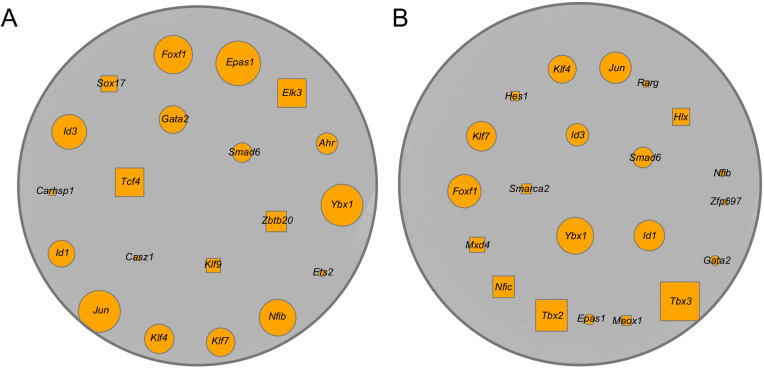
Predicted key transcription factors (TFs) for the endothelial capillary subtypes.The predicted transcriptional regulatory network (TRN) for general capillary cells (A) and aerocytes (B) by SINCERA. Top 25 predicted TFs, from control and IH-exposed mice, are selected, and the overlapped TFs are shown in the figure. Orange nodes represent TFs, gray nodes represent target genes, and edges represent the predicted regulatory interactions between TFs and target genes. The shared TFs between general capillary cells and aerocytes are indicated with circle nodes, and the remaining TFs are indicated with square nodes. The size is in concordance with the average ranking; the higher the ranking, the larger the size.